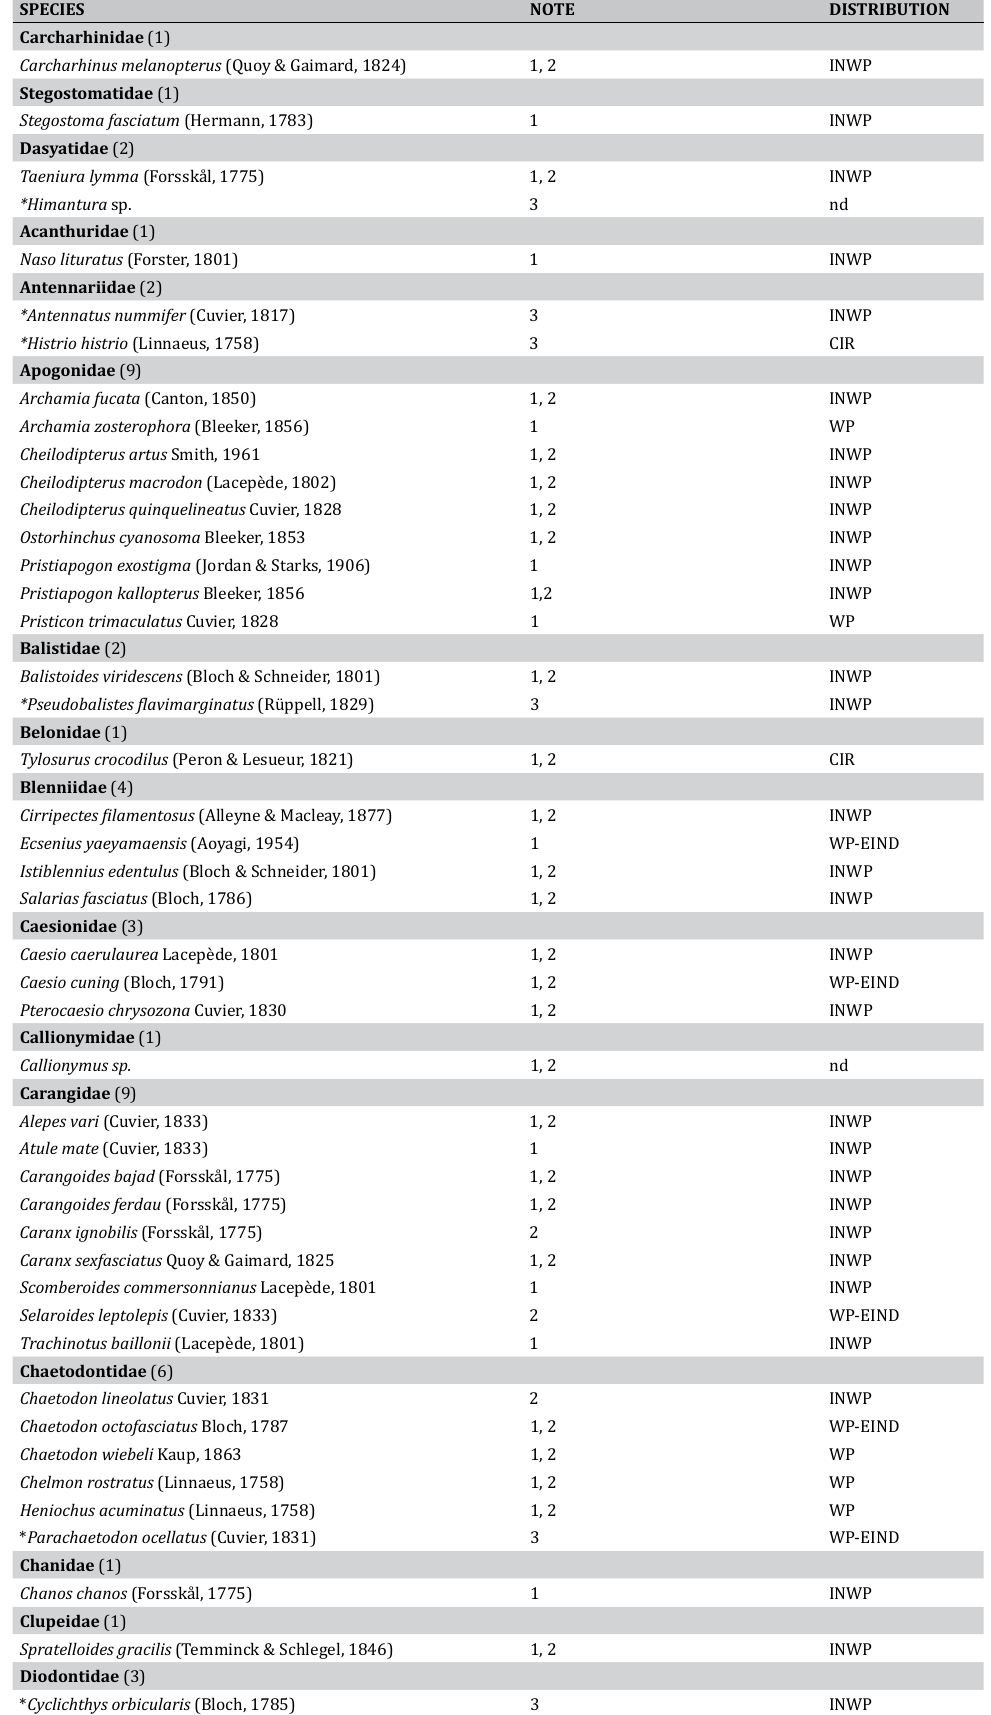
TABLE 1. Fish species recorded at Koh Tao with note on its record (1 = Satapoomin, 2000; 2 = Scaps, 2006; 3 = this study). Genera and species are arranged alphabetically within each family. An asterisk denotes a new record for Koh Tao. The categories of zoogeographical distribution of fishes are Circumtropical (CIR), Indo-west Pacific (INWP), West Pacific (WP), Indo-Malayan (IM), Indo-Australian (IA) and eastern Indian Ocean (EIND). The other notation (nd) marks that the distribution range is not determined. SPECIES NOTE DISTRIBUTION